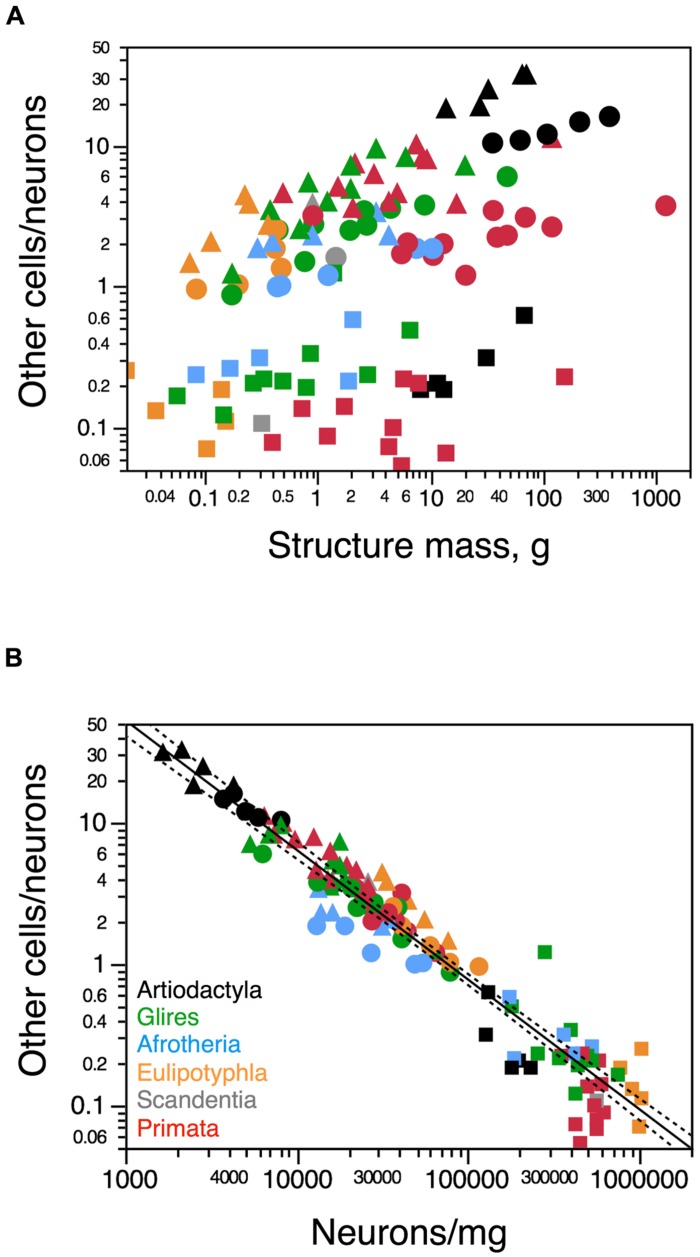
Uniform variation in the O/N ratio with neuronal density, but not structure mass. (A) Ratio between numbers of other (non-neuronal) and neuronal cells, O/N, varies in no uniform fashion across structures (cerebral cortex, circles; cerebellum, squares; rest of brain, triangles) and species (each symbol) as a function of the mass of each structure. (B) In contrast, the O/N ratio varies uniformly across brain structures and species as a function of average neuronal density in the structure. The power function plotted in b applies to the non-artiodactyl species in the sample, and has and exponent of -0.917 ± 0.028. Artiodactyl species in black, primates in red, glires in green, afrotherians in blue, insectivores in orange, scandentia in gray. Data from Herculano-Houzel et al. (2006, 2007, 2011), Azevedo et al. (2009), Sarko et al. (2009), Gabi et al. (2010) and Neves et al. (2014).